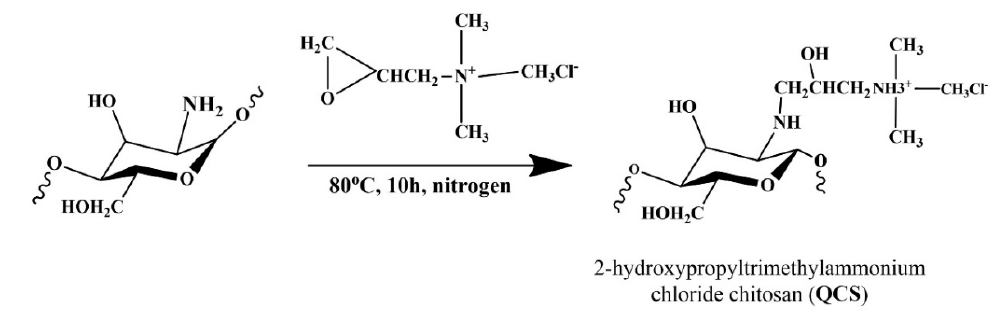
Figure 2. Synthesis of quaternized chitosan (QCS).